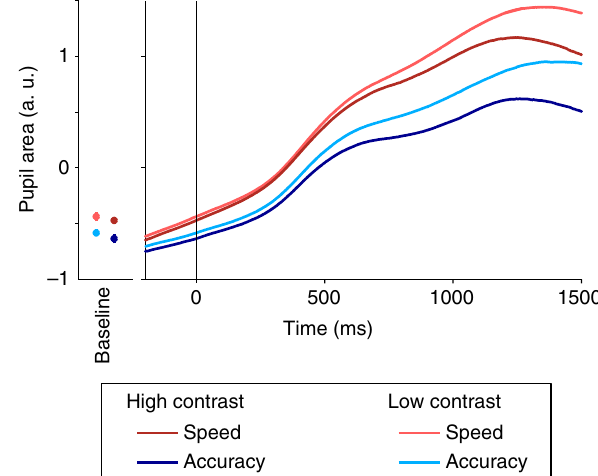
Left/Right × Pupil: F (1,15) = 10.8, p = 0.0050; Supplementary